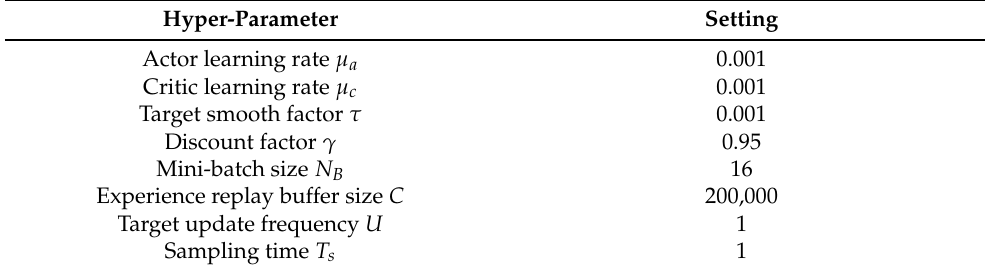
Table 1. Proposed DDPG hyper-parameter settings. Hyper-Parameter Setting Actor learning rate µ a 0.001 Critic learning rate µ c 0.001 Target smooth factor τ 0.001 Discount factor